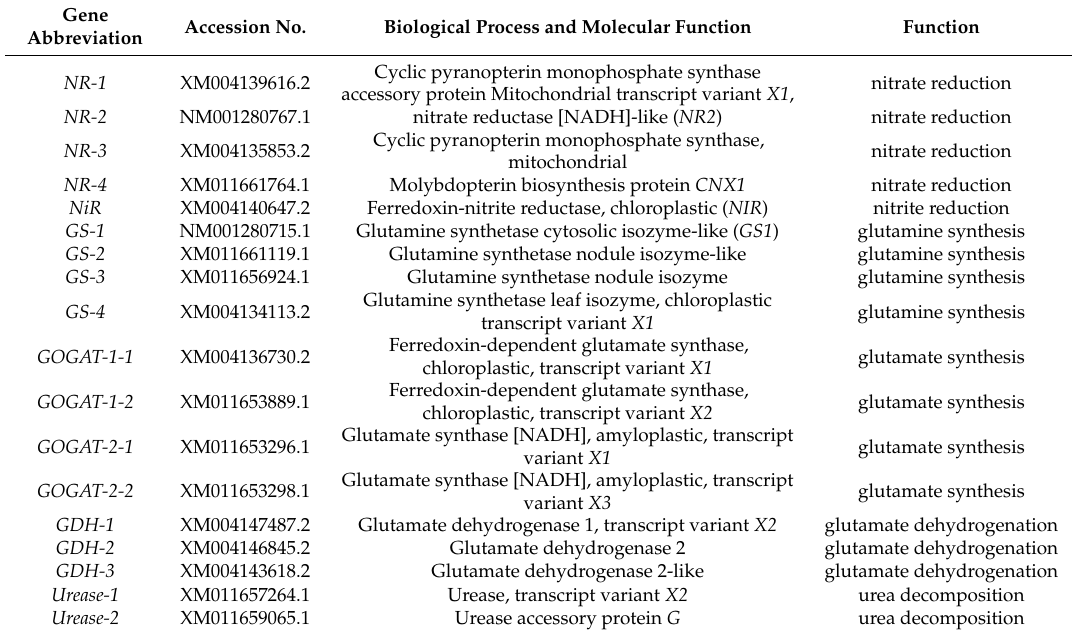
Table 2. List of 18 genes related to nitrogen metabolism in cucumber.